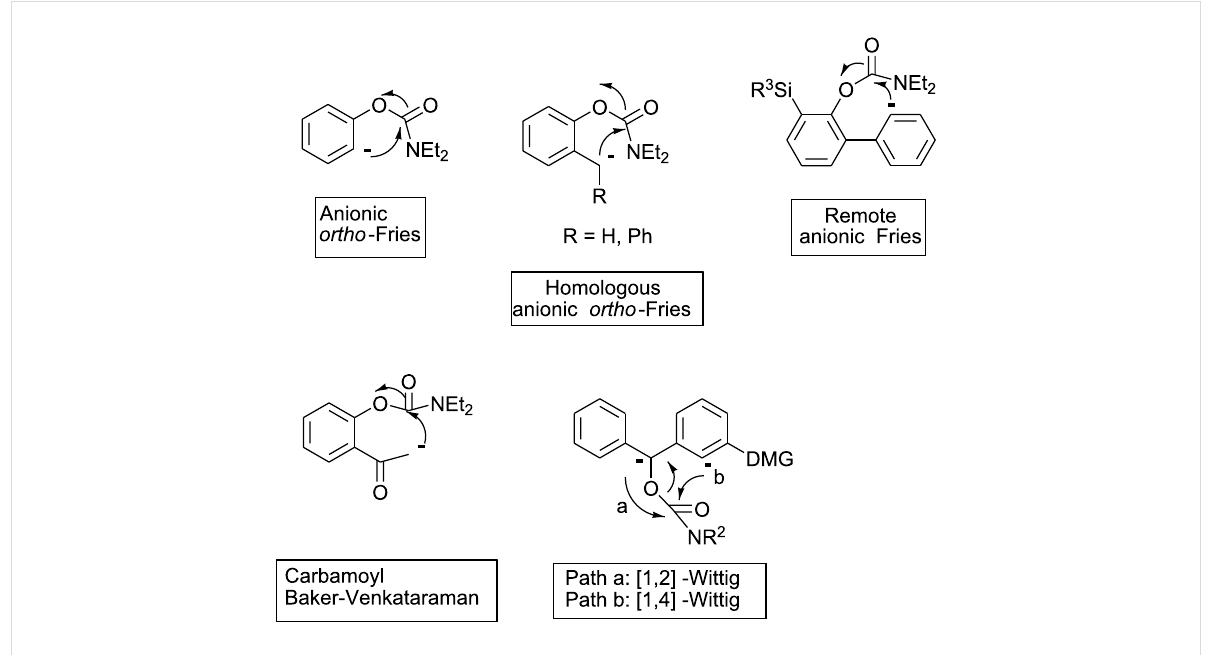
Figure 1: Examples of carbanionic aromatic chemistry rearrangements.